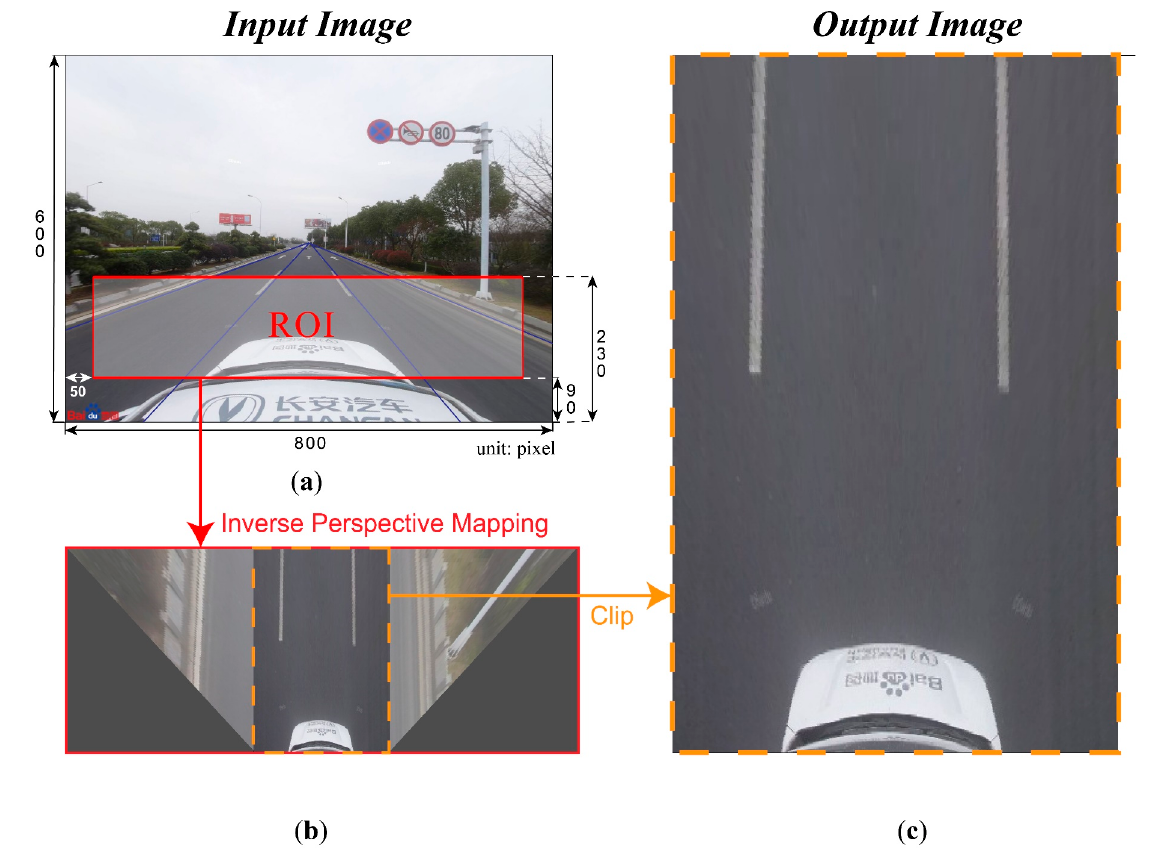
Figure 5. The conversion process of BSV from horizontal to vertical: ( a ) the ROI range for IPM on BSV, ( b ) the transformed image of panel ( a ) using inverse perspective mapping, and ( c ) the output image of the conversion process.